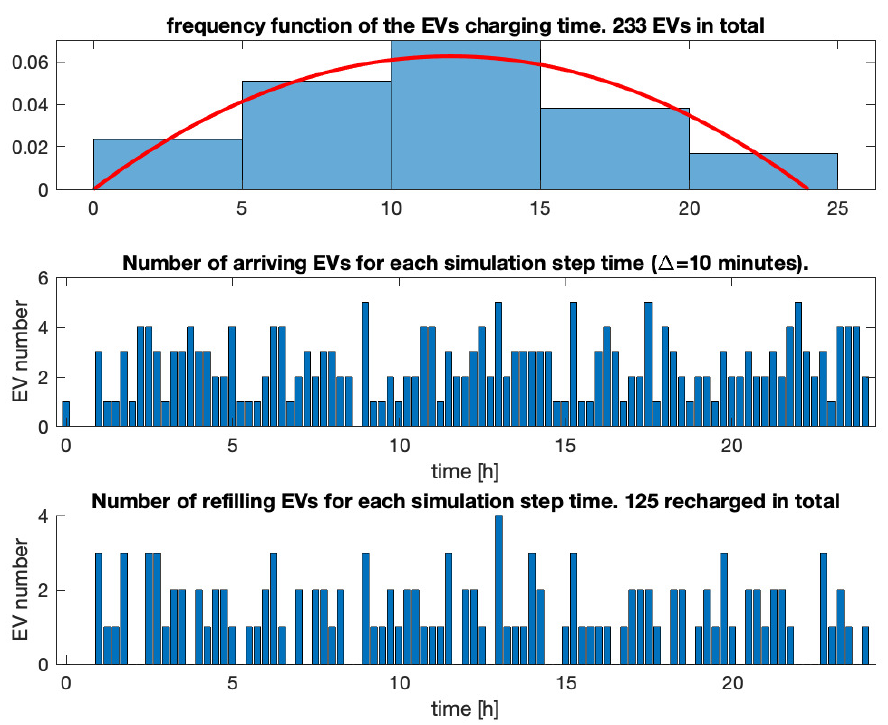
Figure 5. Normal distribution of EVs per day with hourly detail and number of uncharged vehicles. From the UFCS as an additional power source, the UFCS has a 900 kW peak power photovoltaic plant P PV . The first subplot of Figure 6 shows the maximum level of power that the UFCS can use, P net + P PV , and other relevant power used to ensure grid stability. By referring to the Figure 1 scheme, the UFCS has eight EVSE each with 800 kW peak power. The BESS’ power contribution was limited to 800 kW in the charging mode and 200 kW in discharging mode, and had a storage capacity of 4 MWh. The EVs’ parameters were generated as random numbers in a range similar to that defined by the market. The EVSE power is generated in the range of 400–800 kW, whereas the storage size is in the range of 225–800 kWh. All details of the simulation settings are reported in Table 1. Furthermore, the BESS is forced to help the grid in the case of the presence of EMVs, resulting in a positive effect in terms of reducing the charging